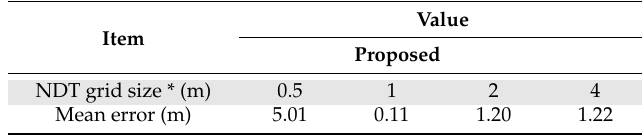
Table 4. The proposed framework’s sensitivity to different NDT grid sizes. Value Item Proposed